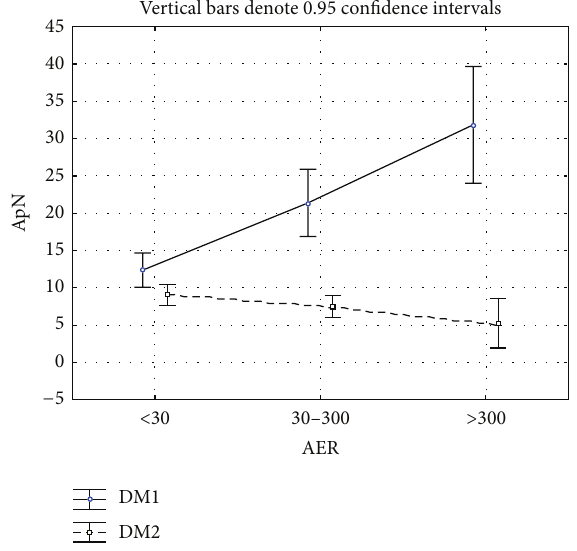
Figure 1: ApN mean values and 95% confidence intervals in patients with type 1 and type 2 diabetes according to